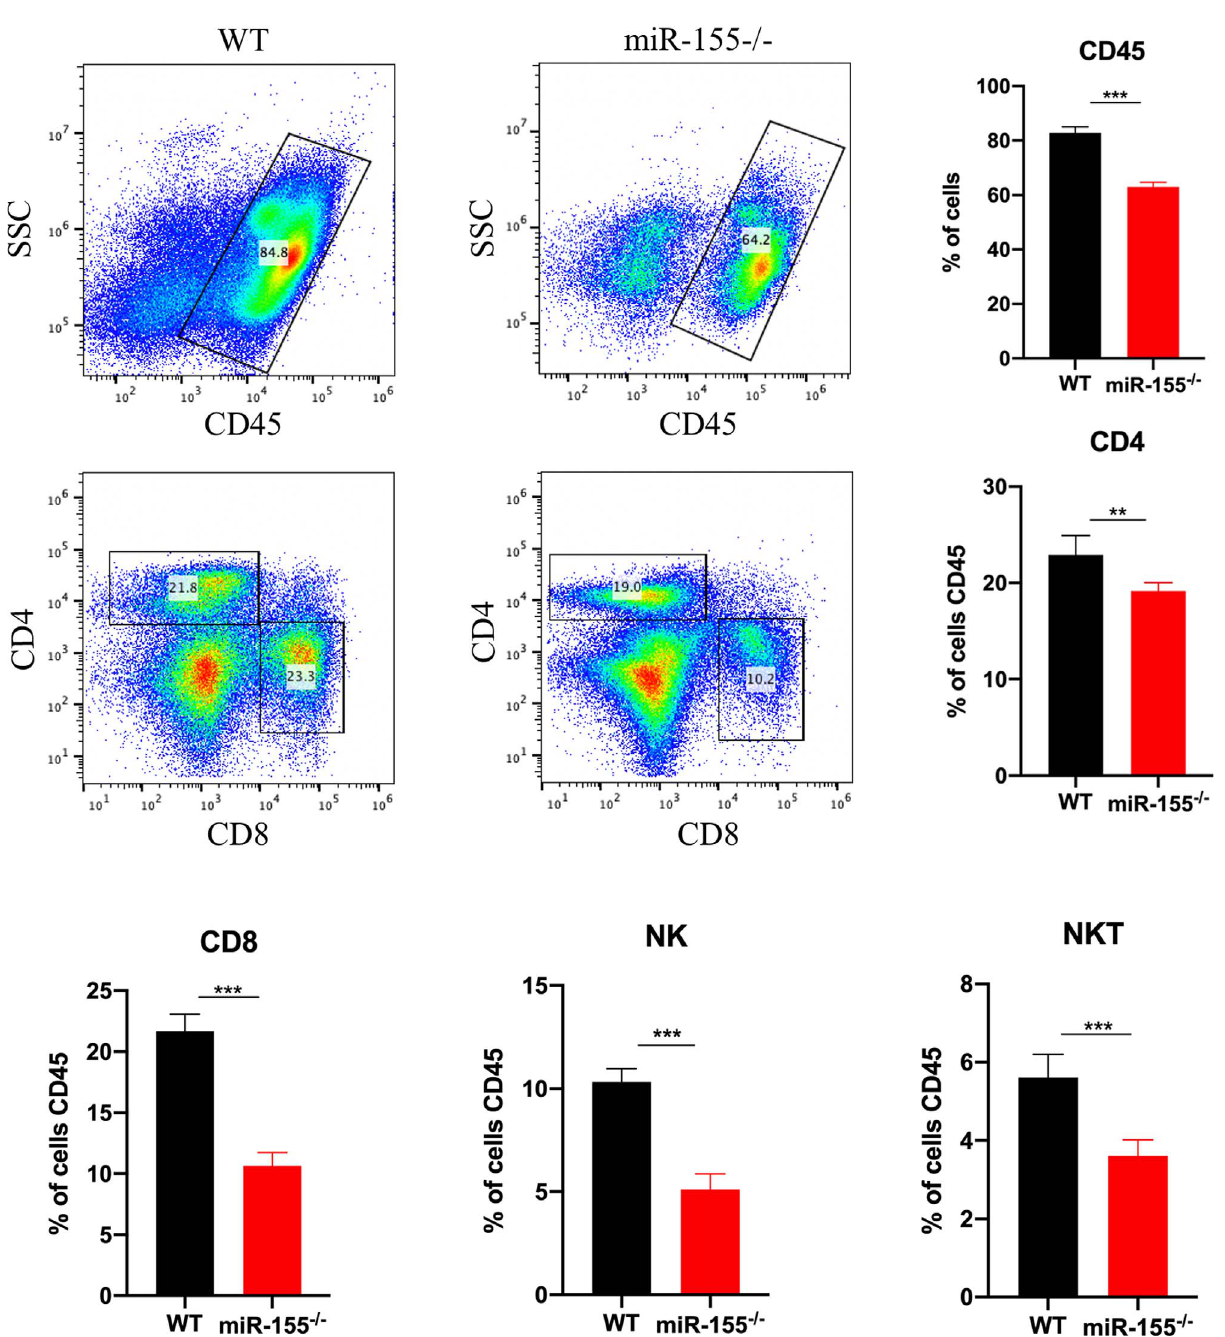
Figure 3. miR-155 de fi ciency impairs the recruitment of CD4 + T cells, CD8 + T cells, NK and NKT cell. Spleens were collected from each mouse in the WT and miR-155 (cid:1) / (cid:1) groups. The splenocytes labeled with cell-speci fi c fl uorescent labeled antibodies were analysed by fl ow cytometry. Results were calculated and expressed as a mean ± SD of three independent experiments. *** p < 0.001; ** p <